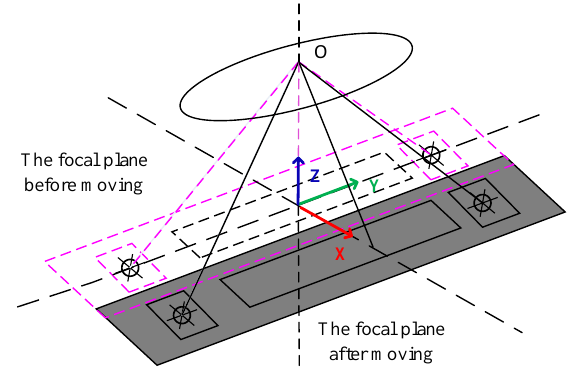
Figure 10. Visual axis rotates around the